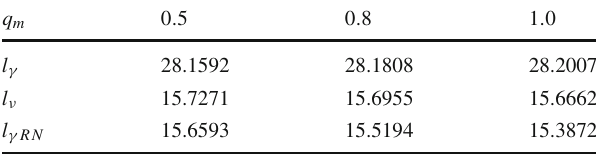
Table 4 The impact parameters of null geodesics for two representative values of magnetic charge parameter q m , presented in Fig.